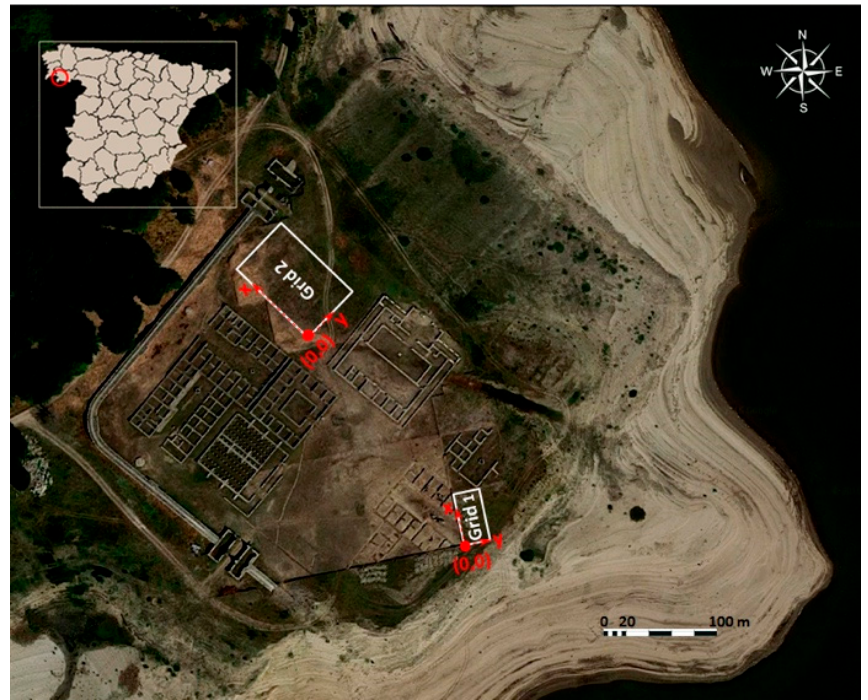
Figure 1. Situation of the Roman site “ Aquis Querquennis ” in Galicia (Northwest of Spain) and grids surveyed with the ground-penetrating radar (GPR) technique.